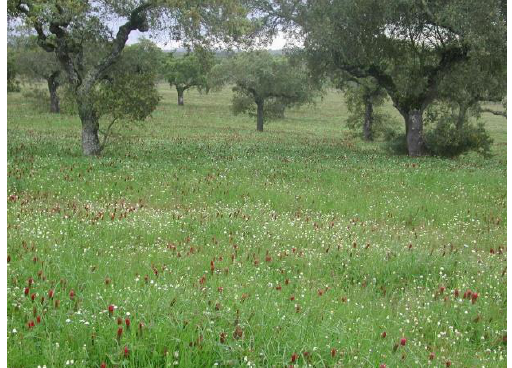
Figure 1. Partial view of a Portuguese agroforestry system with Quercus sp. and a biodiverse pas-